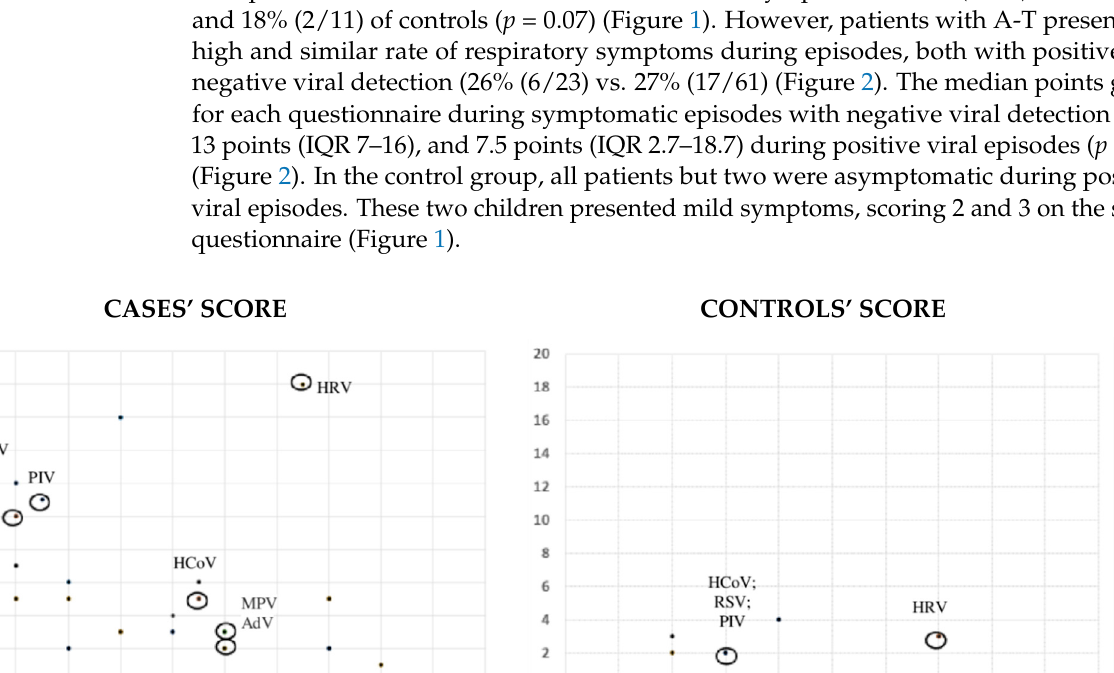
Eight patients with A-T (72%) and two controls (18%) presented respiratory symptoms during the study ( p = 0.01), associated or not with respiratory virus isolation. Episodes with positive viral detection were associated with symptoms in 54% (6/11) of A-T cases and 18% (2/11) of controls ( p = 0.07) (Figure 1). However, patients with A-T presented a high and similar rate of respiratory symptoms during episodes, both with positive and